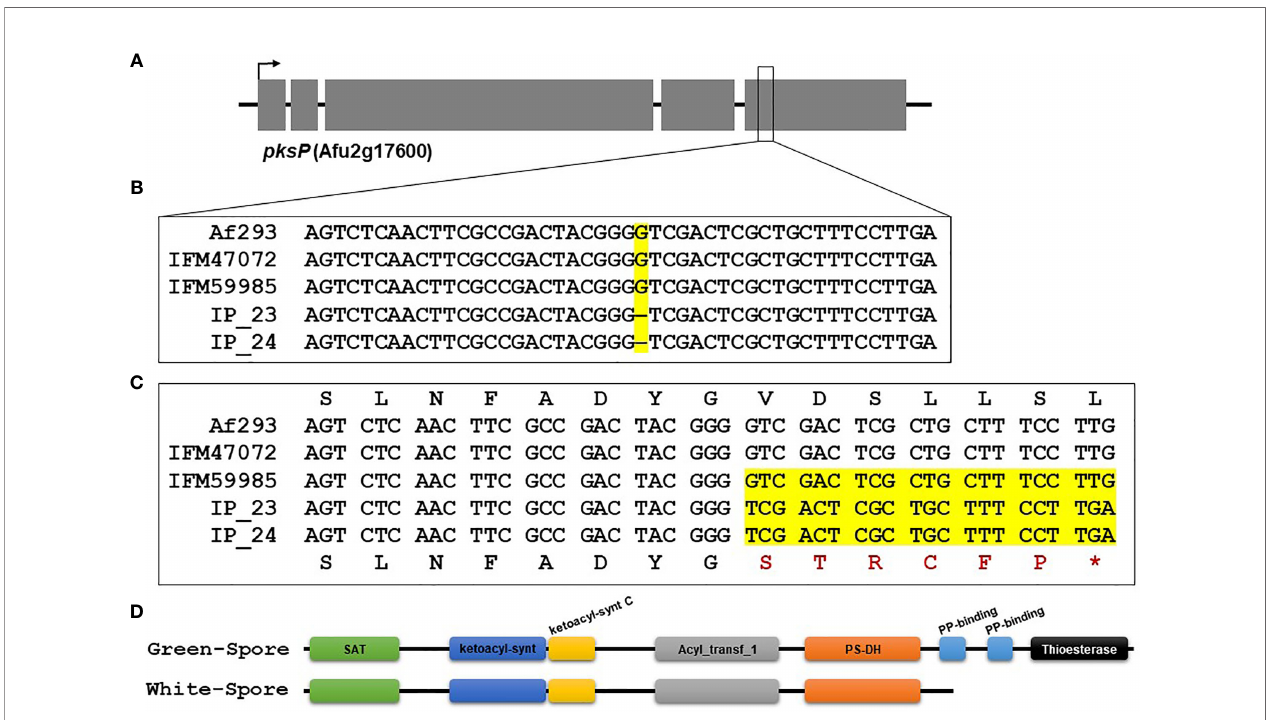
FIGURE 3 | Single nucleotide deletion in pksP results in a truncated protein in IP_23 and IP_24. (A) Schematic of the pksP gene. The arrow represents the direction of transcription, and grey boxes represent exons. (B) Alignment of the region containing the single nucleotide deletion in IP_23 and IP_24 isolates. The yellow region highlights the mutation. (C) Translated region containing the single nucleotide deletion. The yellow region shows the single nucleotide deletion, resulting frameshift and premature stop codon (*). (D) Protein schematic of PksP in the green-spore and white-spore isolates. Colored ellipses represent PFAM domains. The white- spore PksP is truncated and missing 1 and a half PP-binding domains and the thioesterase